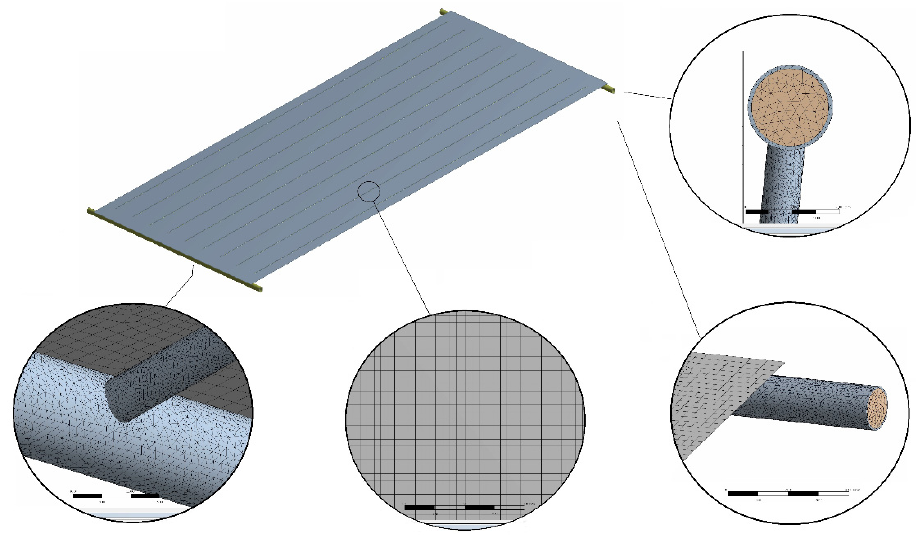
Figure 4. Mesh setup for the solar collector